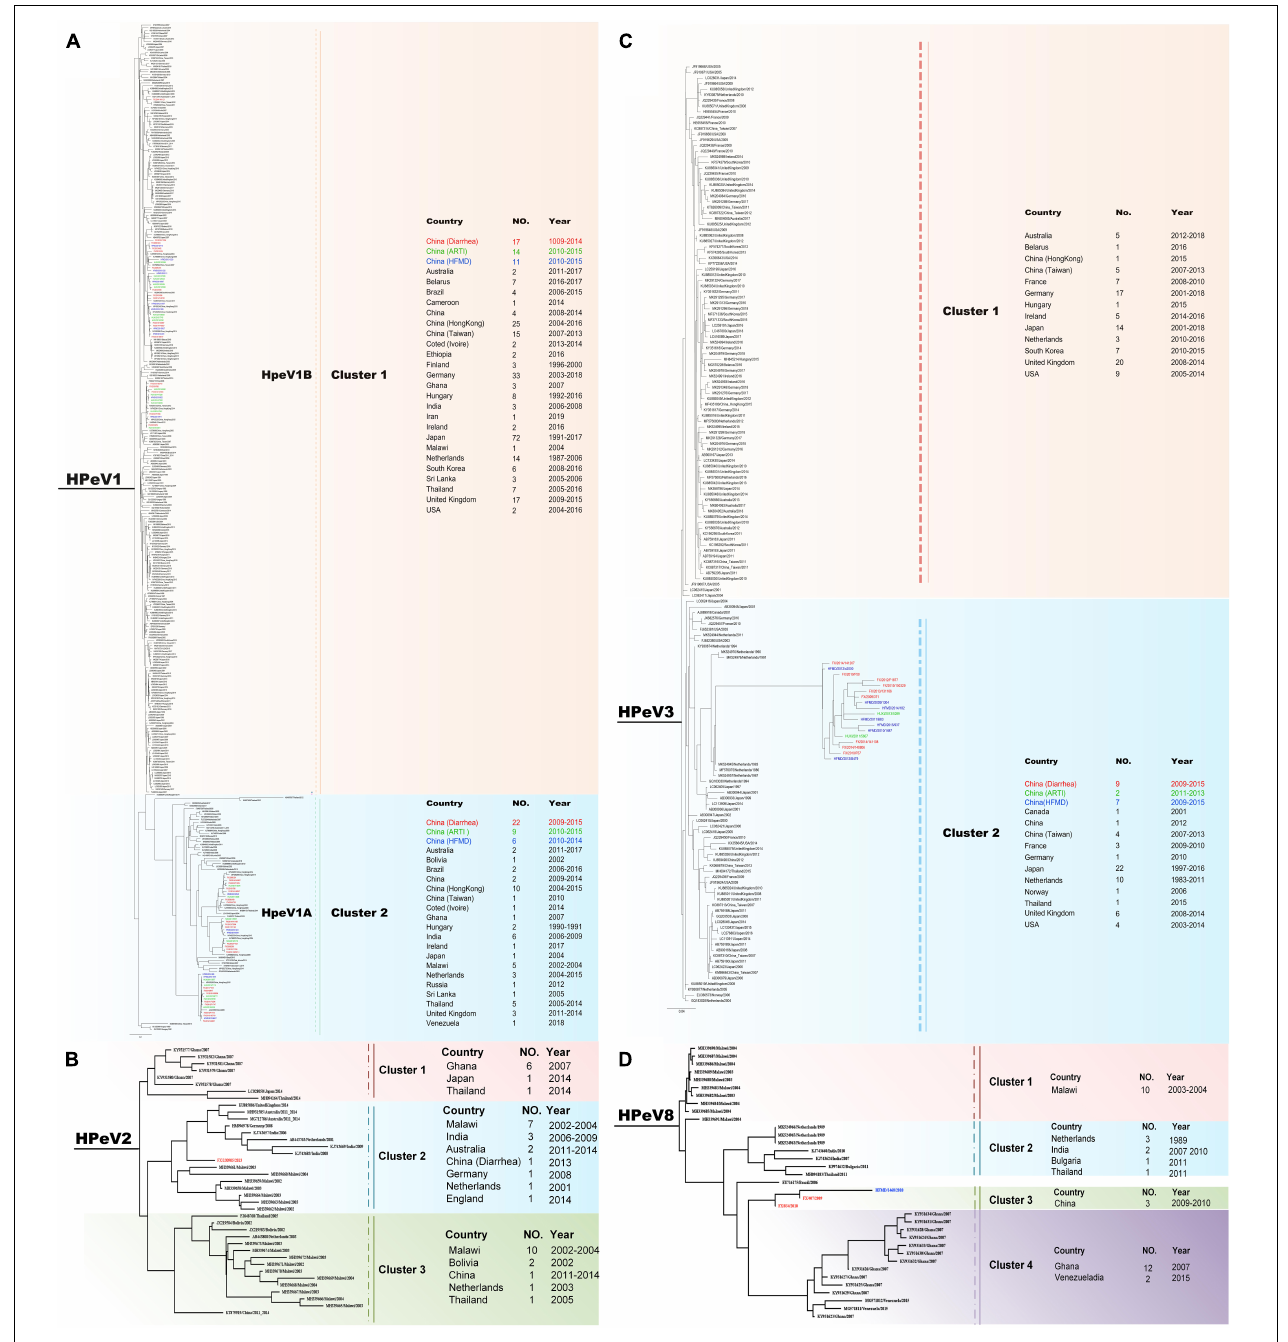
FIGURE 3 | Phylogenetic analysis of all the HPeV1-3 and 8 strains based on the compete VP1 sequence. (A) Phylogenetic analysis of representative HPeV1 strains based on the compete VP1 sequence. (B) Phylogenetic analysis of all the HPeV2 strains based on the compete VP1 sequence. (C) Phylogenetic analysis of representative HPeV3 strains based on the compete VP1 sequence. (D) Phylogenetic analysis of all the HPeV8 strains based on the compete VP1 sequence. The phylogenetic trees were constructed with maximum likelihood method with 1,000 replicates using MEGA 7.0. The strains of black names were downloaded from GenBank and others were from our study. The strains of green names with the beginning of “HUXI” were isolated from Group 2 (patients with acute respiratory tract infection). The strains of red names with the beginning of “FX” were isolated from Group 2 (patients with diarrhea). The strains of blue names with the beginning of “HFMD” were isolated from Group 3 (patients with hand-foot-mouth